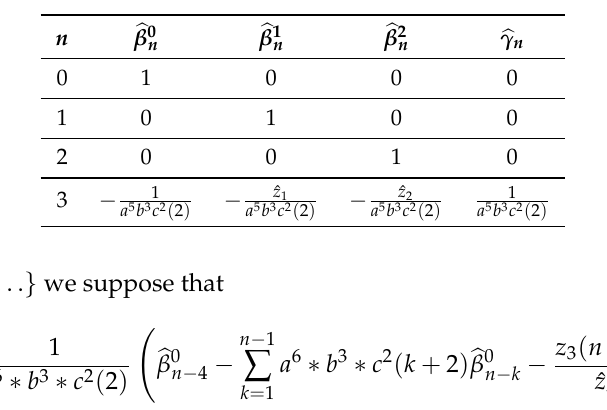
Table 3. Initial values of sequences (cid:98) β 0 n , (cid:98) β 1 n , (cid:98) β 2 n and (cid:98) γ n